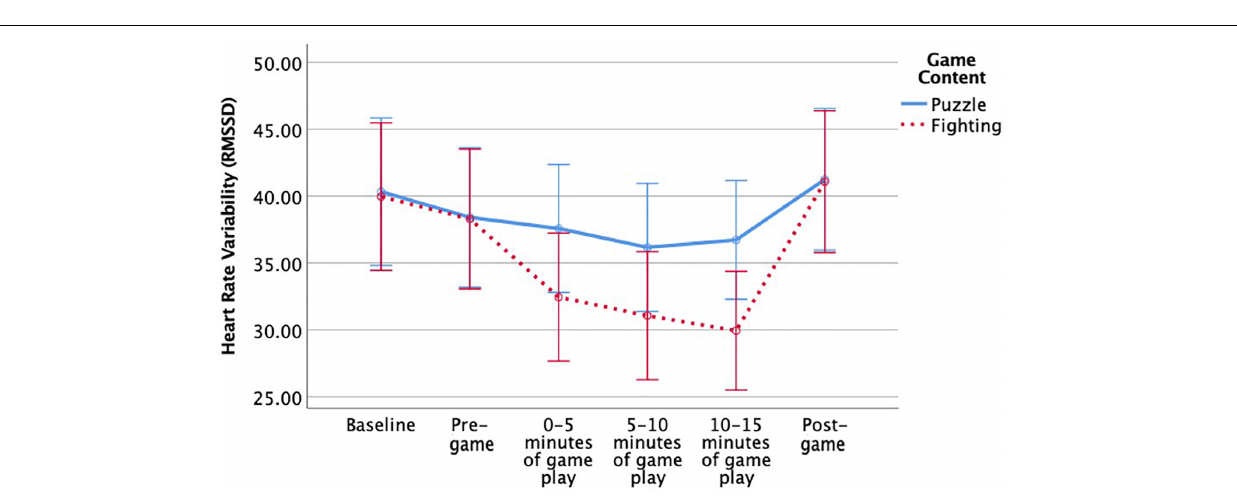
FIGURE 2 | Significant interaction effect of game content on heart rate variability over time. Error bars are 95% confidence intervals.